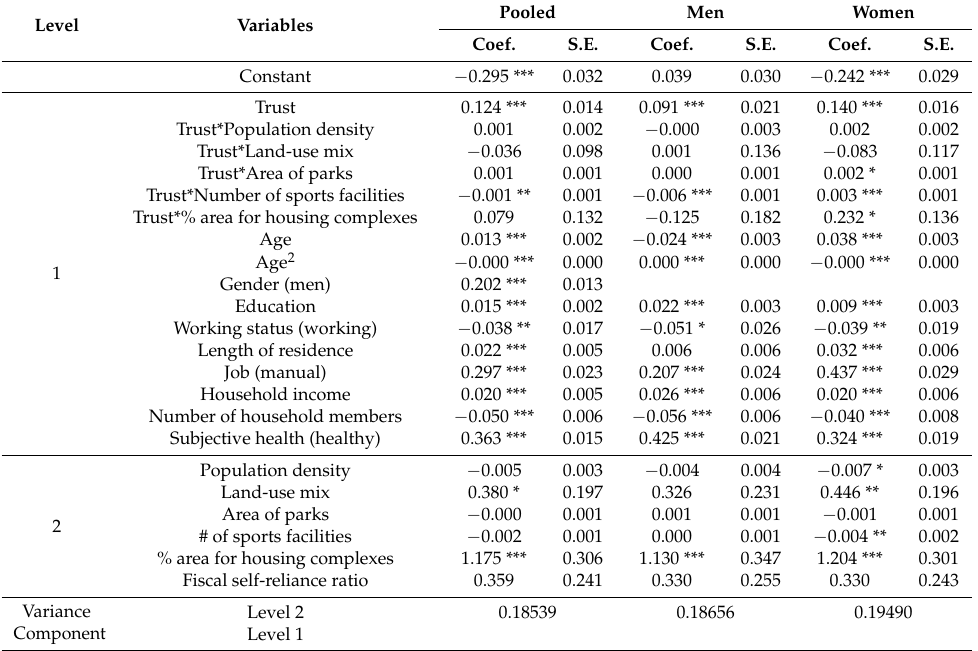
Table 3. Multi-Level Estimates: Trust